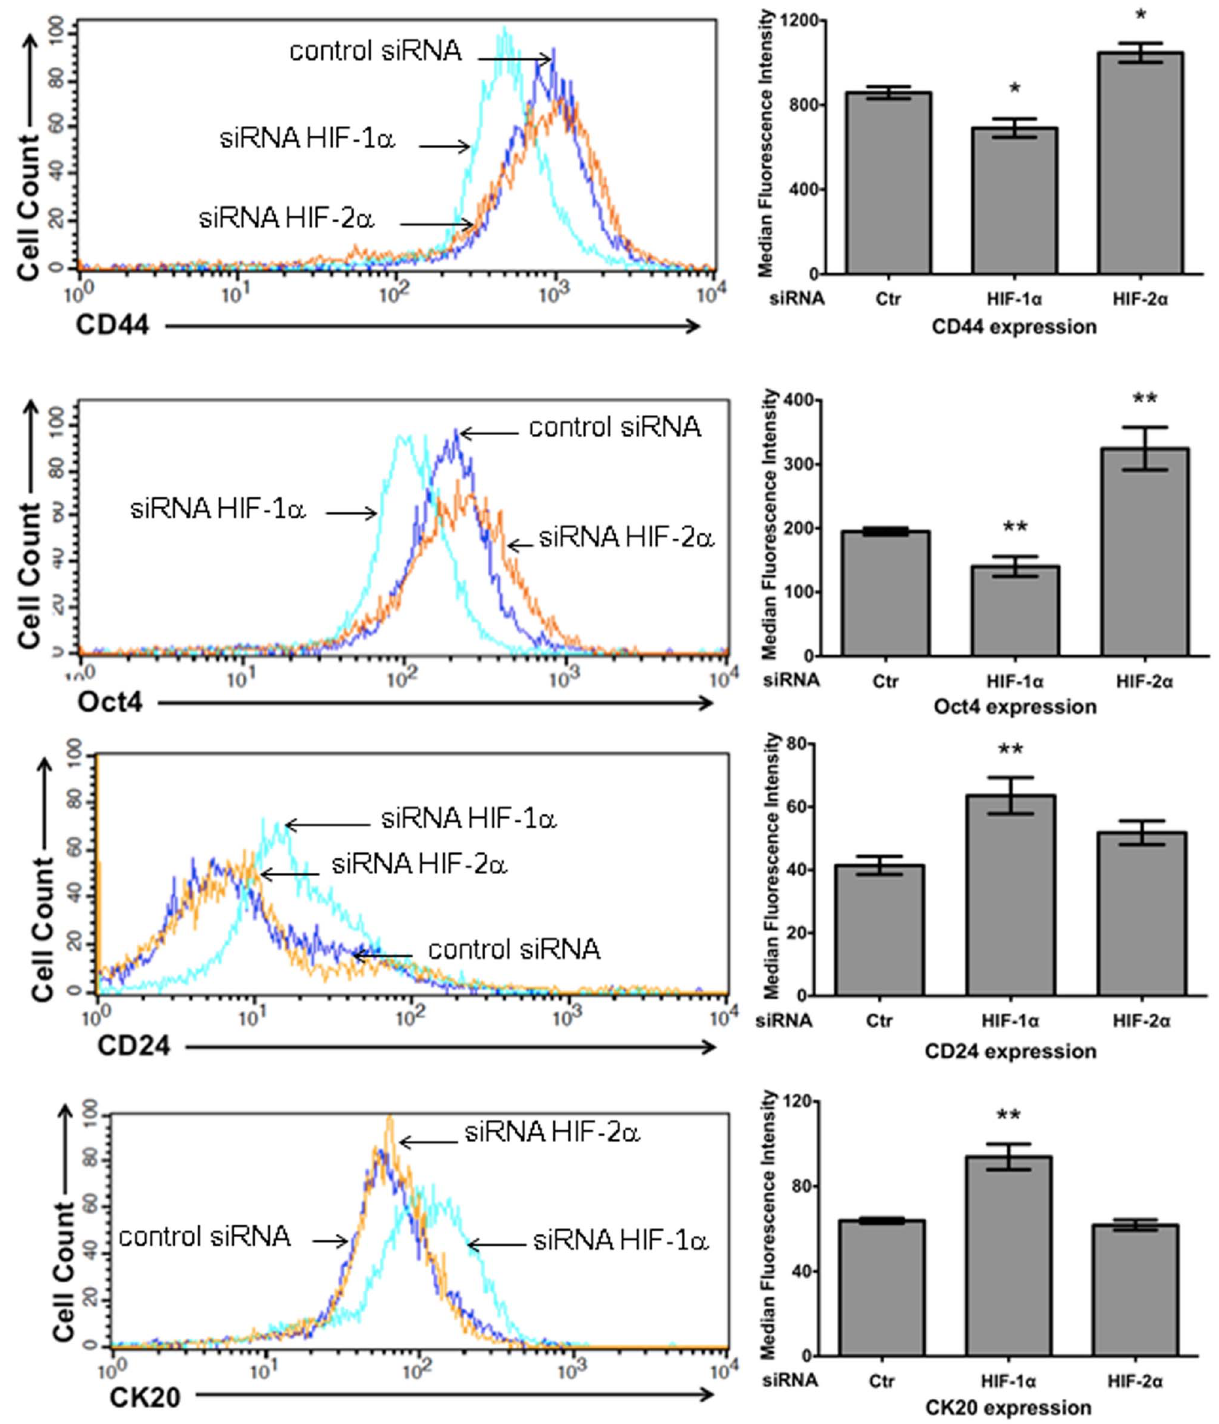
Figure 9. HIF-1 a and HIF-2 a knockdown exerted opposing effects on the expression of the stem cell markers CD44 and Oct4, but only HIF-1 a depletion increased the expression of the differentiation marker CK20. Stable control (scrambled shRNA plasmid) or HIF-1 a - or HIF-2 a - silenced SW480 cells were incubated in the presence of EDTA, washed, and incubated with mouse anti-CD44, rabbit anti-Oct4, mouse anti- CD24 or mouse anti-CK20 antibodies. The cells were washed, stained with Alexa 647-conjugated goat anti-mouse/rabbit secondary antibody, and examined by flow cytometry. The figure shows the overlapping histograms of labeled SW480 control cells (blue line and Ctr in each bar graph), HIF- 1 a -knockdown cells (green line), and HIF-2 a -knockdown cells (orange line). A representative histogram of the data is shown, and the bar graphs represent the means of the median fluorescence intensity 6 SEM from at least four independent experiments. *: p , 0.05; **: p , 0.01.